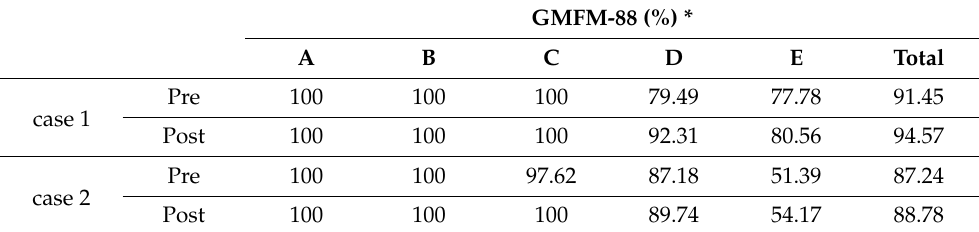
Table 3. Changes in GMFM after RAGT intervention.